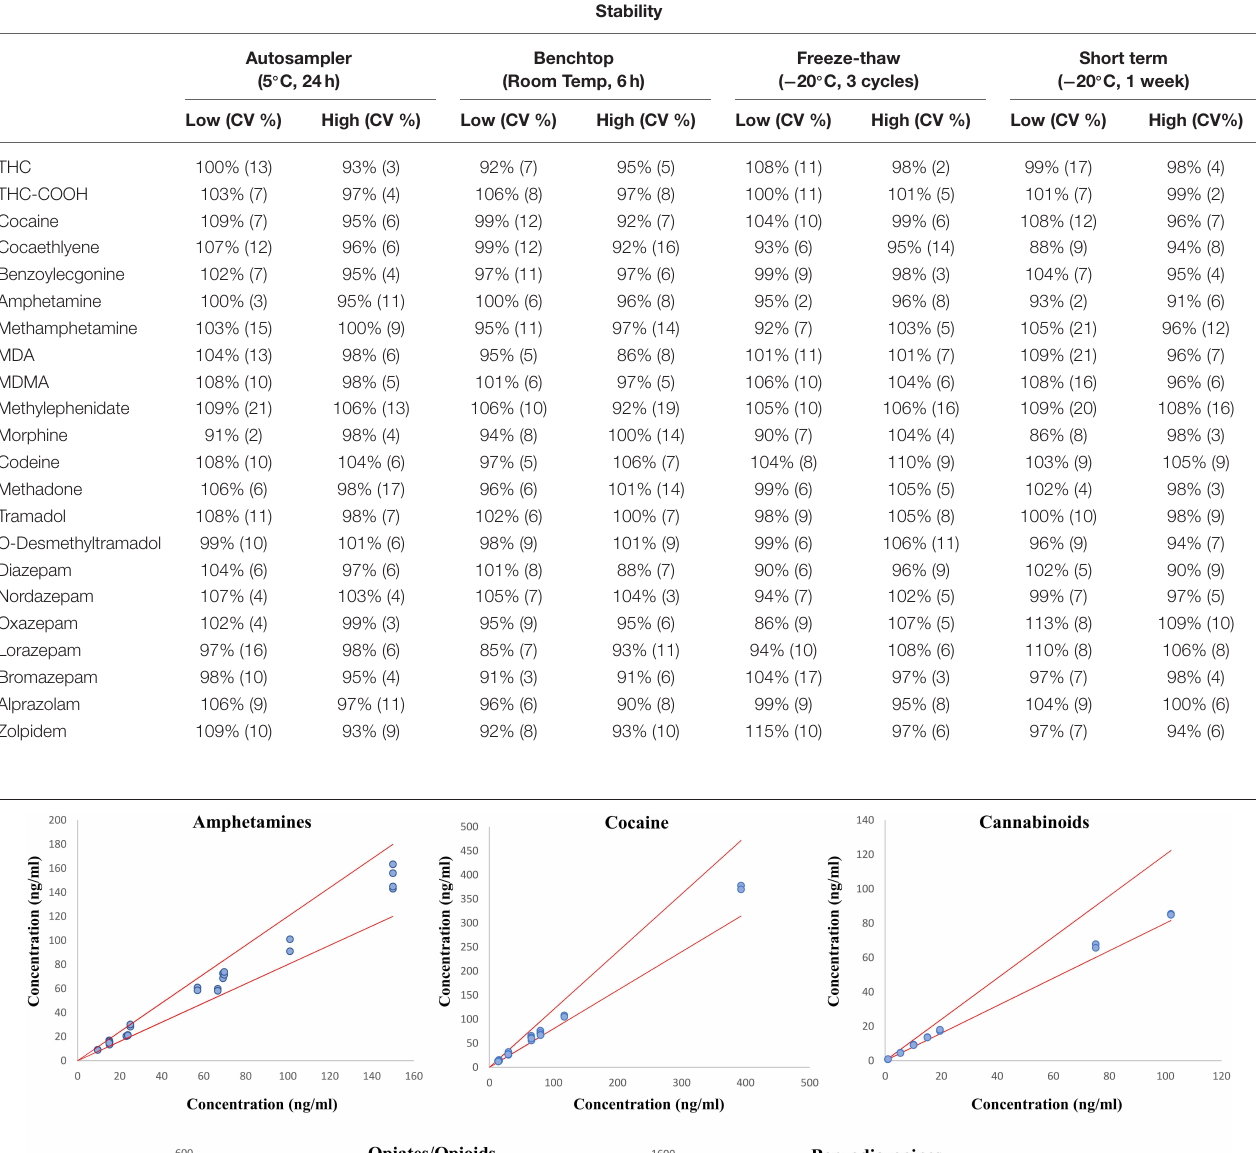
TABLE 4 | Three cycles of freeze-thaw ( − 20 ◦ C), benchtop (6h, room temperature), autosampler (24h, 5 ◦ C), and short-term (1 week, − 20 ◦ C) conditions were performed in this stability assay at low- and high-quality control concentrations.